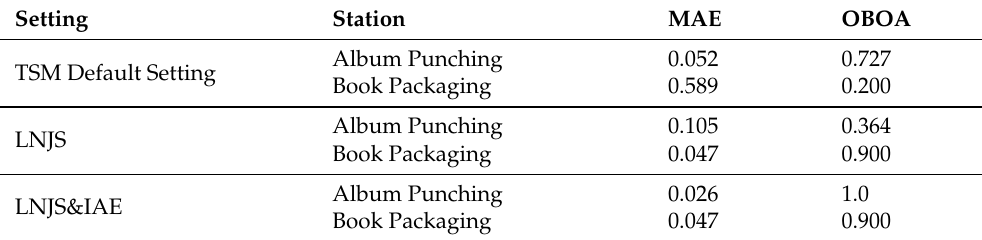
Figure 11. Experimental results of optimal strategy of label number jumping suppression. Table 2. Performance of optimization strategy